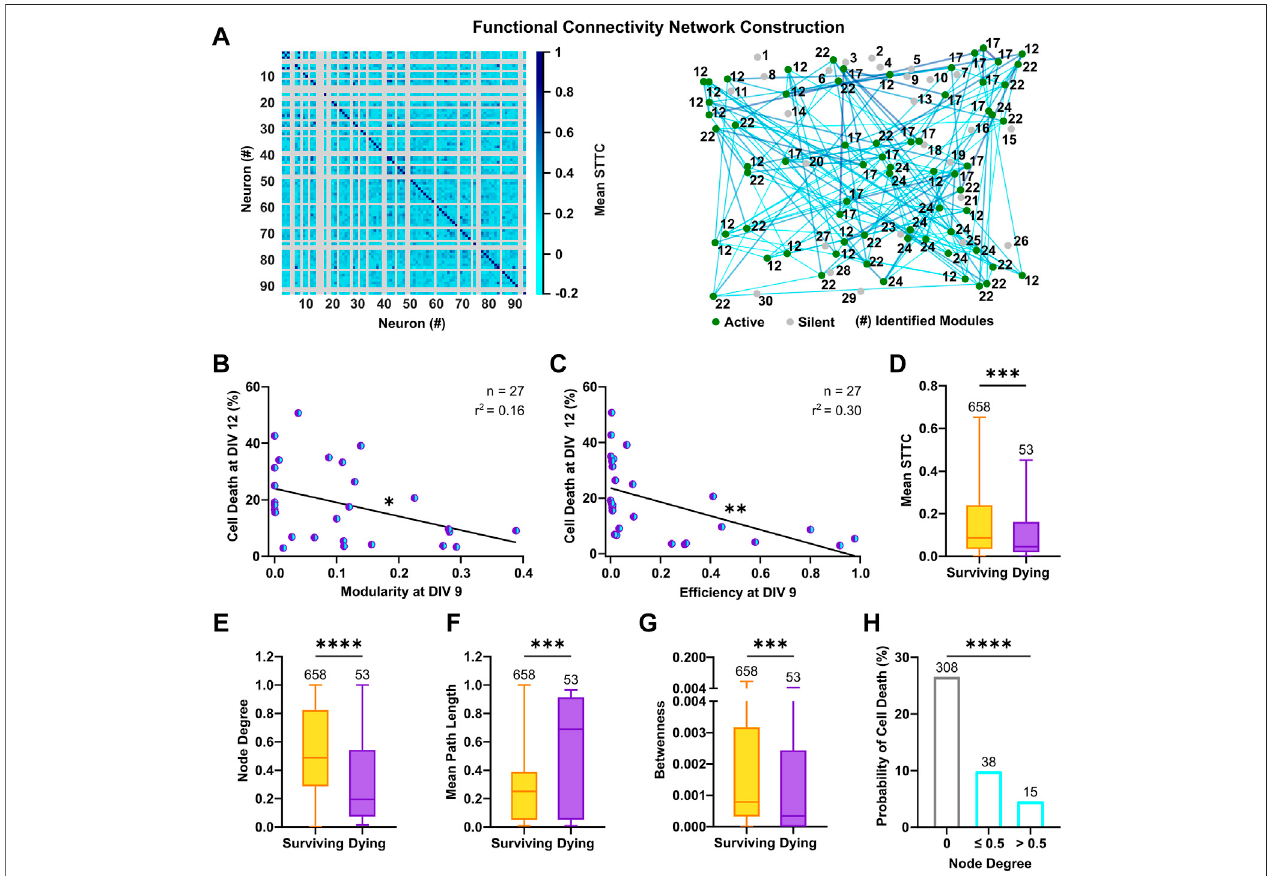
FIGURE6| Functionalconnectivityfostersneuronalsurvivalinculture. (A) Representativeconnectivitymatrix(left)andnetworkgraph(right)of93neuronsatDIV9. Active (green) and silent neurons (gray) are shown in their physical positions with respective module numbers and representative functional connections (cyan-blue) are drawn between active neurons. (B,C) Modularity and ef fi ciency ofthe network at DIV 9 were negatively correlated withsubsequent cell death rates at DIV 12(F test). (D) Surviving neurons showed a higher synchrony (mean STTC) with activity of other neurons in culture (Mann-Whitney test). (E) The number of connections (node degree)washigherinsurvivingneuronscomparedtoneuronswithaprospectivedyingfate(Mann-Whitneytest). (F) AveragepathlengthatDIV9waslongerforneurons, which died until DIV 12 (Mann-Whitney test). (G) Surviving neurons had a more central position (betweenness) within connections of others pairs of neurons (Mann- Whitneytest). (H) Theprobabilityofcelldeathwaslowerinneuronswithahighernodedegree(Chi-squaretest).BoxplotswithmedianandIQRandmin – maxwhiskersor scatter plots with line indicating simple linear regression are shown. * p < 0.05, *** p < 0.001 and **** p < 0.0001.